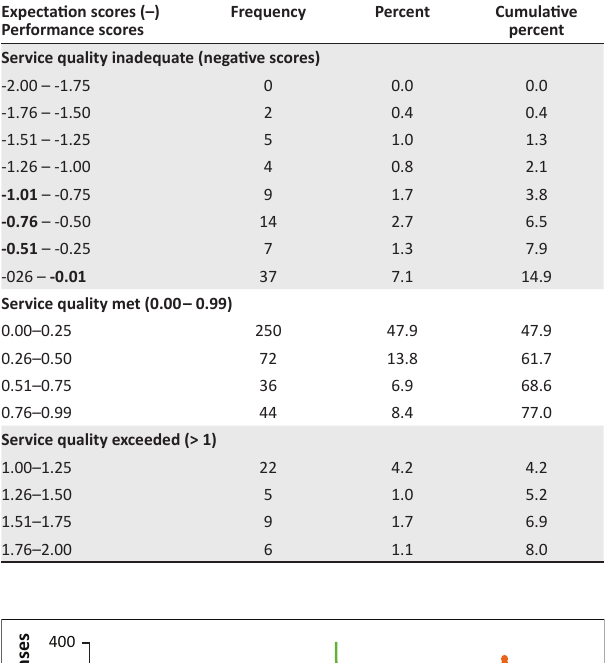
TABLE 4: Gap analysis. Expectation scores (–) Performance scores